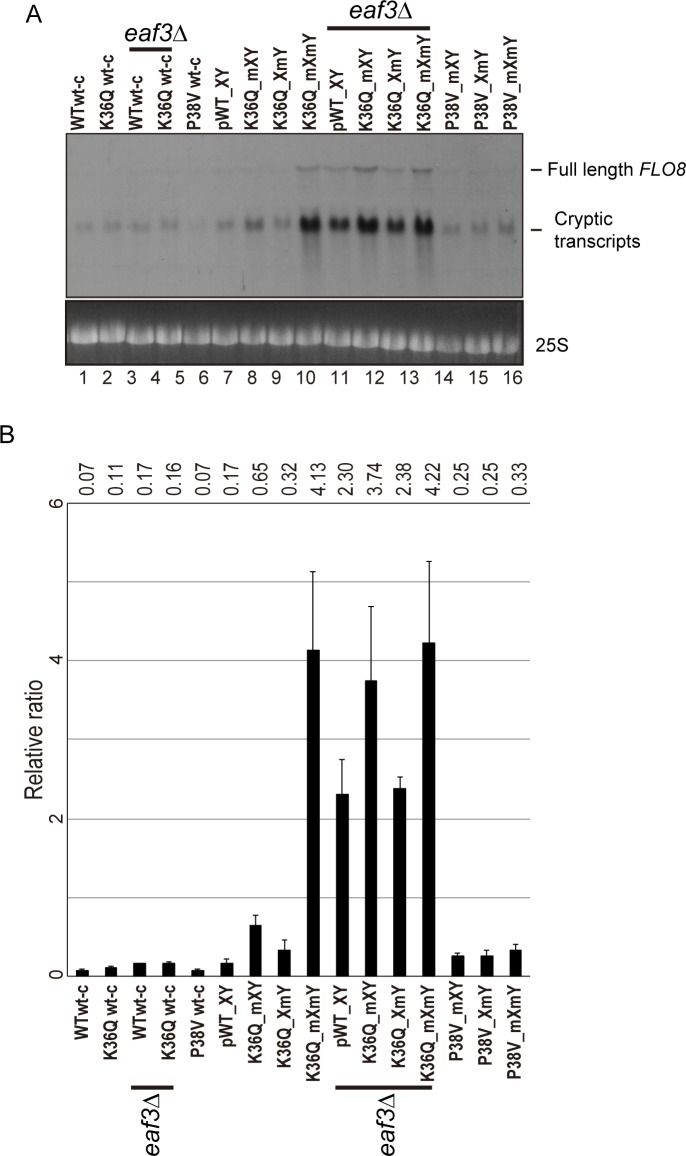
Effects of H3K36Q mutants on cryptic transcription.As in Figure 5, with FLO8 used as a probe for Northern blots in place of STE11.